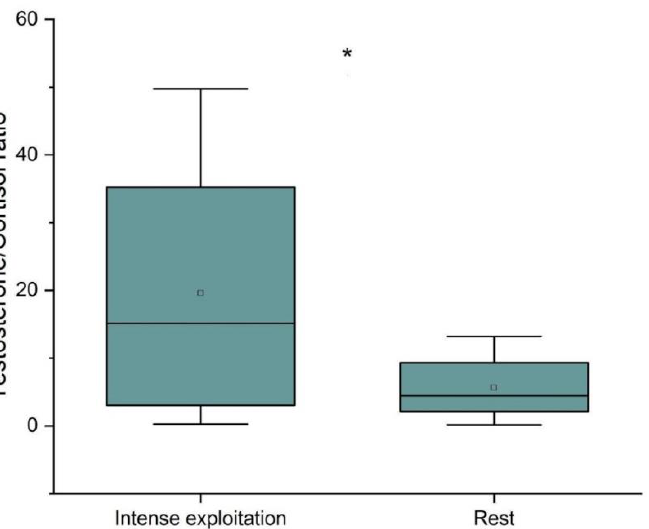
Figure 2. Testosterone/cortisol ratio in two measured points of time. The box plot presents data distribution (mean, median, and interquartile range) among samples of horses included in the analysis ( n = 8). p < 0.09. * p <